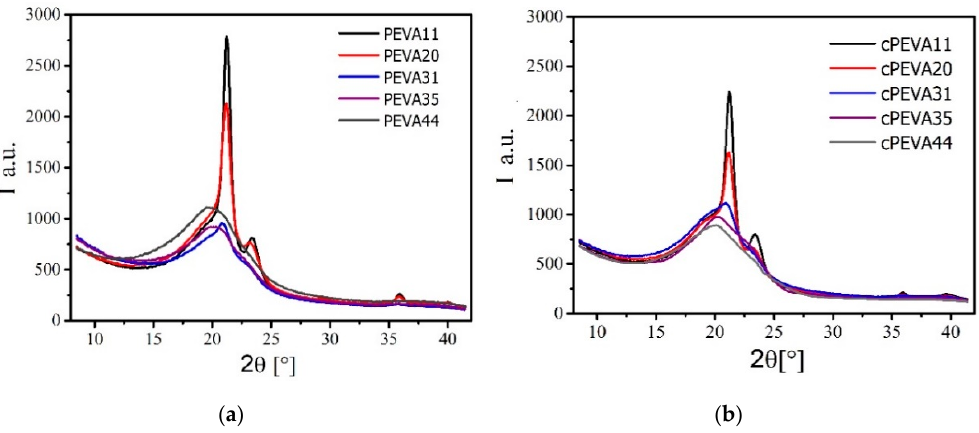
Figure 4. Wide ‐ angle X ‐ ray scattering (WAXS) patterns of PEVAs ( a ) and cPEVAs ( b ) with various VA ‐